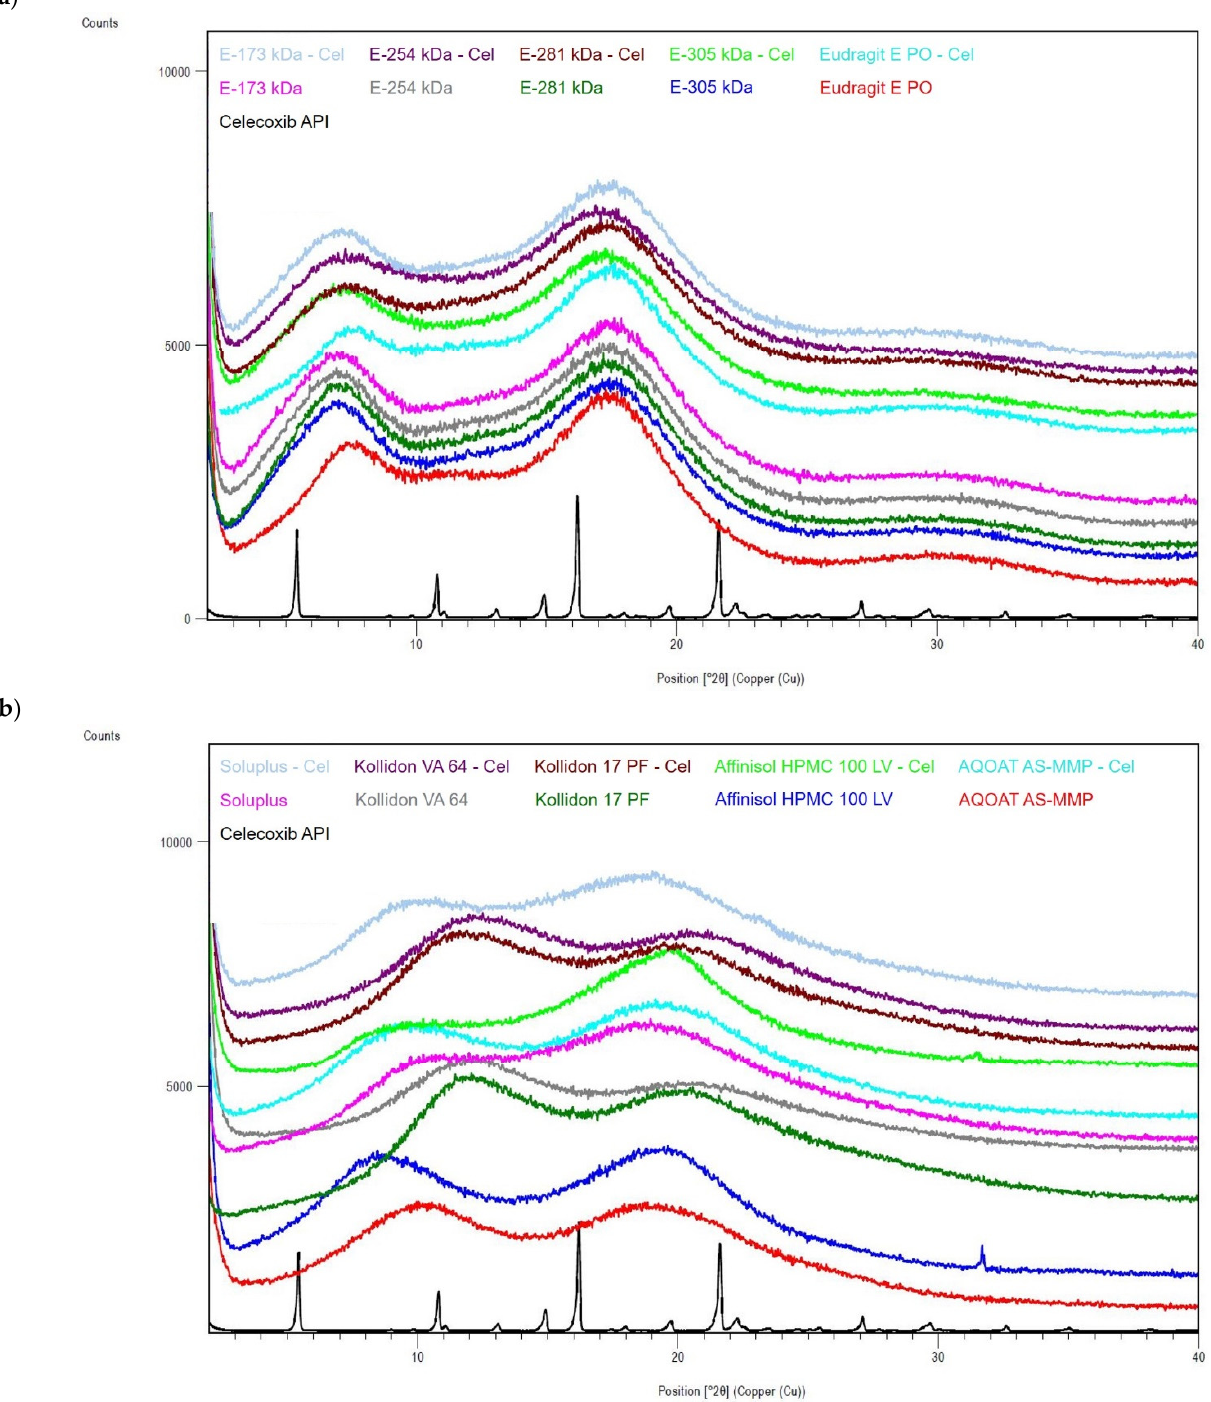
Figure 2. X-ray powder diffraction (XRPD) diffractograms of the drug substance celecoxib, ModE copolymers, EPO and the corresponding ASDs ( a ), as well as celecoxib drug substance, other marketed (co-)polymers (selection) and the corresponding ASDs ( b ).